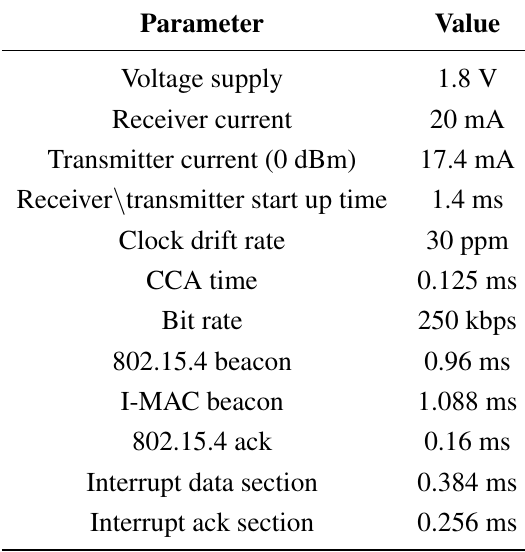
Table 3. Parameters used in the simulation. CCA, clear channel